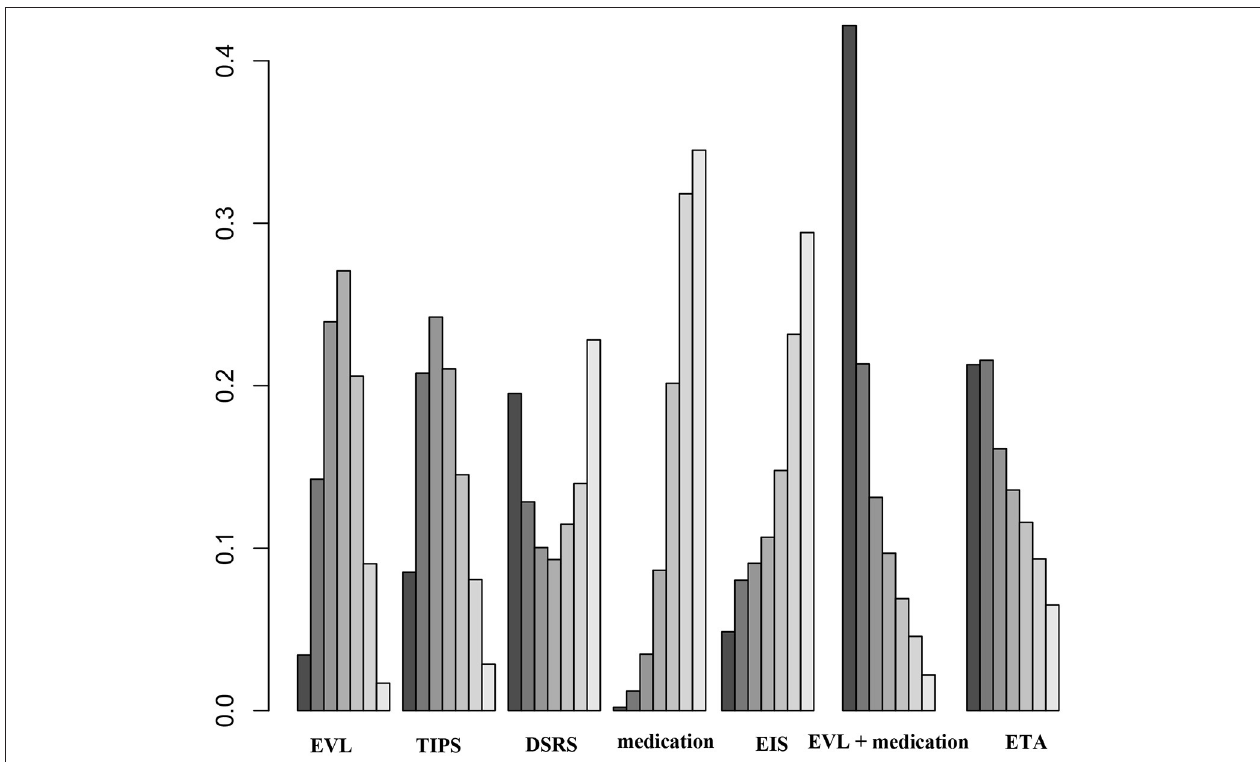
FIGURE 6 | Ranking of 1-year OS among the different therapies. EVL, endoscopic variceal ligation; TIPS, transjugular intrahepatic portosystemic shunt; DSRS, distal splenorenal shunt; EIS, endoscopic injection sclerotherapy; ETA, endoscopic